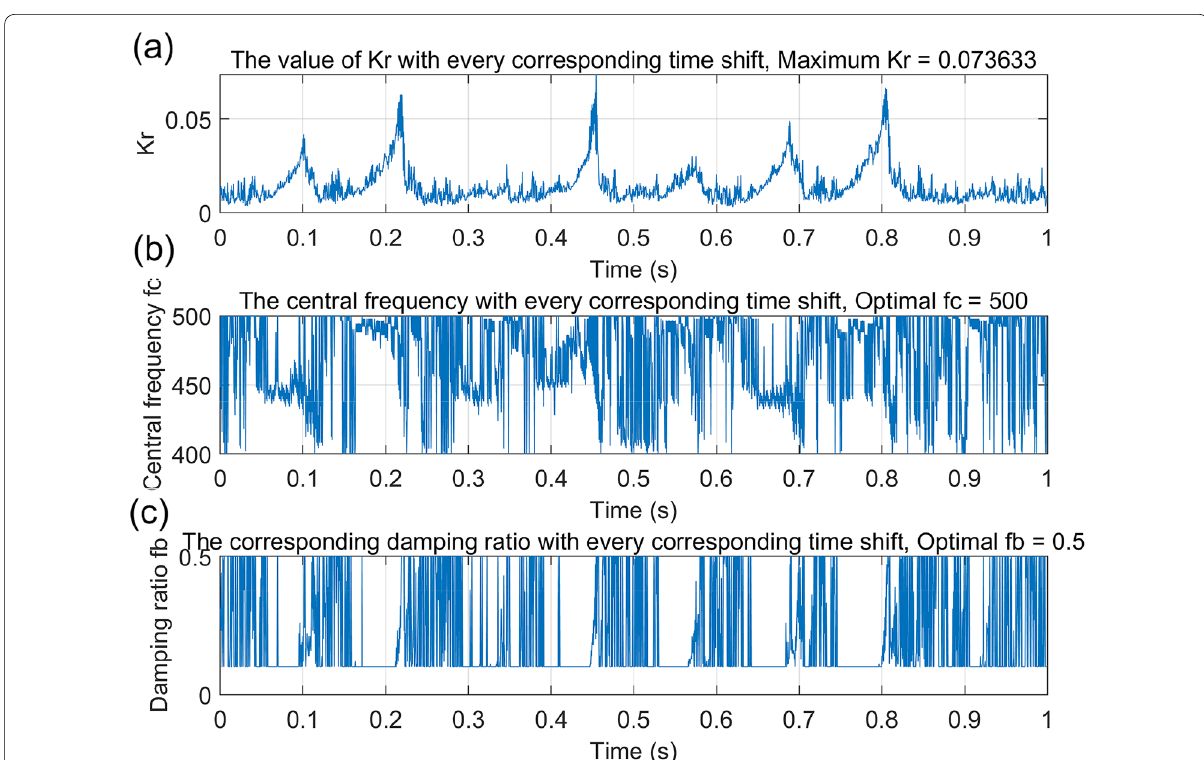
Figure 19 The optimal central frequency and damping ratio were obtained by the maximum correlation coefficient criterion: ( a ) the value of the correlation coefficient with every corresponding time shift, ( b ) the central frequency with every corresponding time shift, and ( c ) the damping ratio with every corresponding time shift